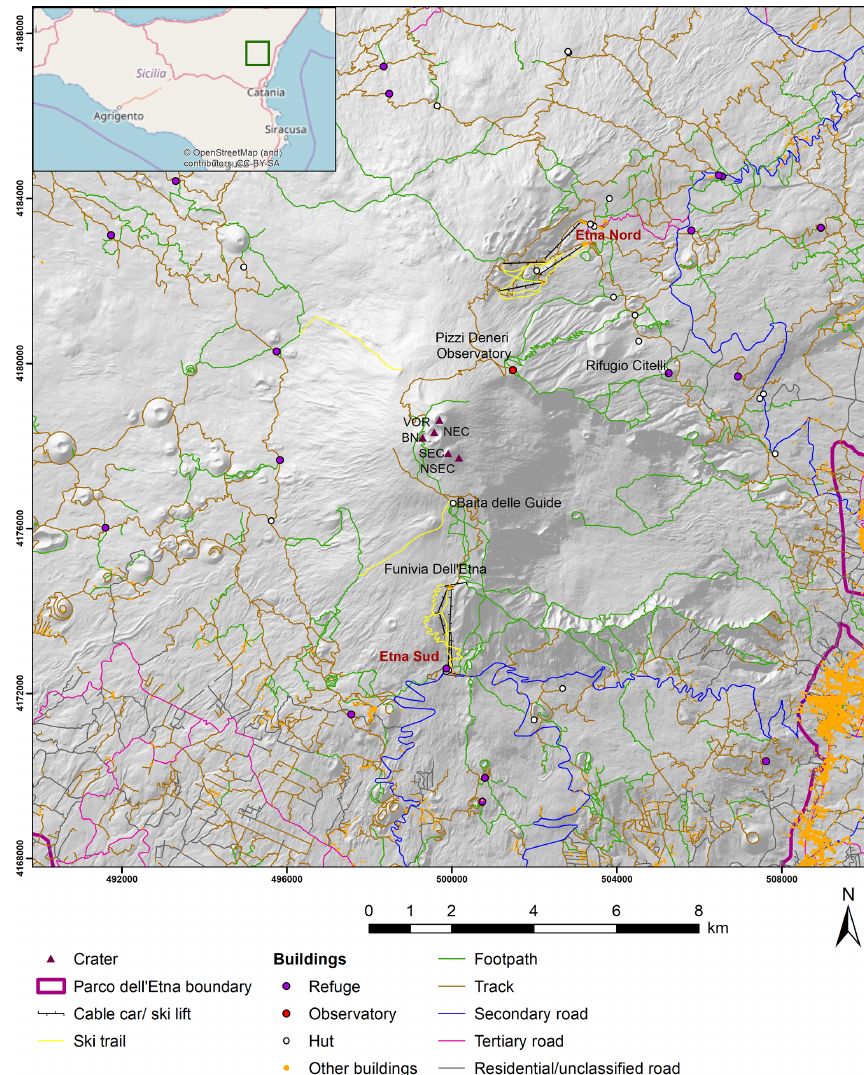
Figure 1. Infrastructure within 10km of the summit area of Mount Etna (data from OpenStreetMap Foundation, 2017a, b). BN: Bocca Nuova; NEC: Northeast Crater; NSEC: New Southeast Crater; SEC: Southeast Crater; VOR: